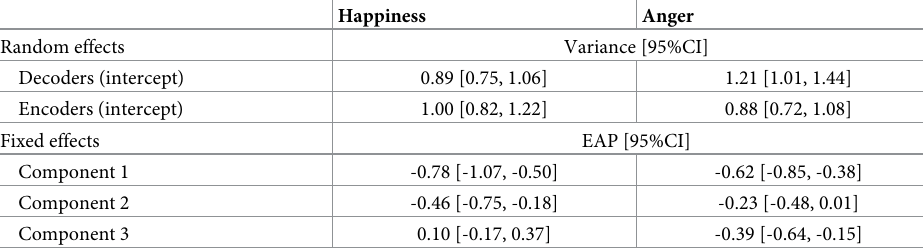
Table 1. Results of the generalized linear mixed model for the relationships between identified NMF patterns and decoders’ dichotomous judgments of genuineness.